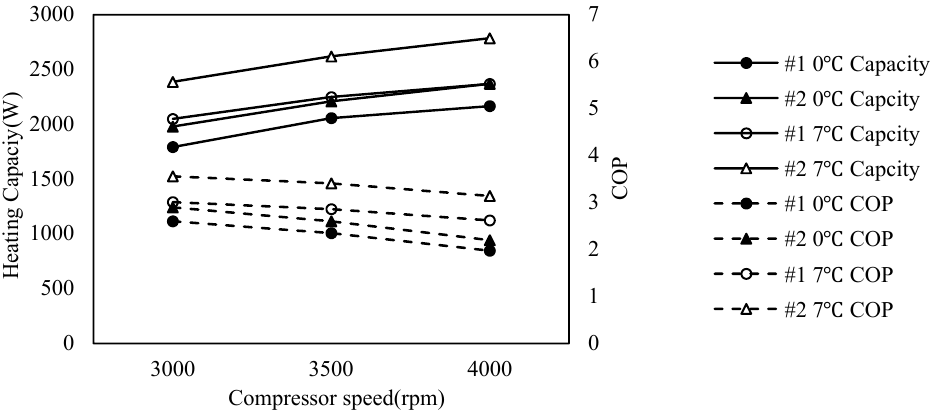
Figure 3. System performance in heating mode. COP, coefficient of performance.